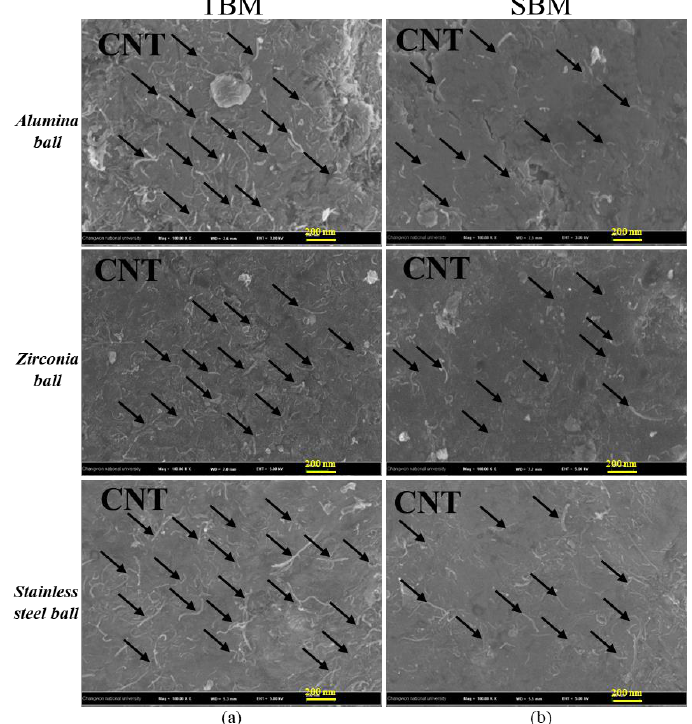
Figure 7. FESEM images (100,000×) of Cu/CNT nanocomposites for 48 h at 50 rpm in both mills ( a ) TBM and ( b ) SBM with three different milling media. and ( b ) SBM with three di ff erent milling